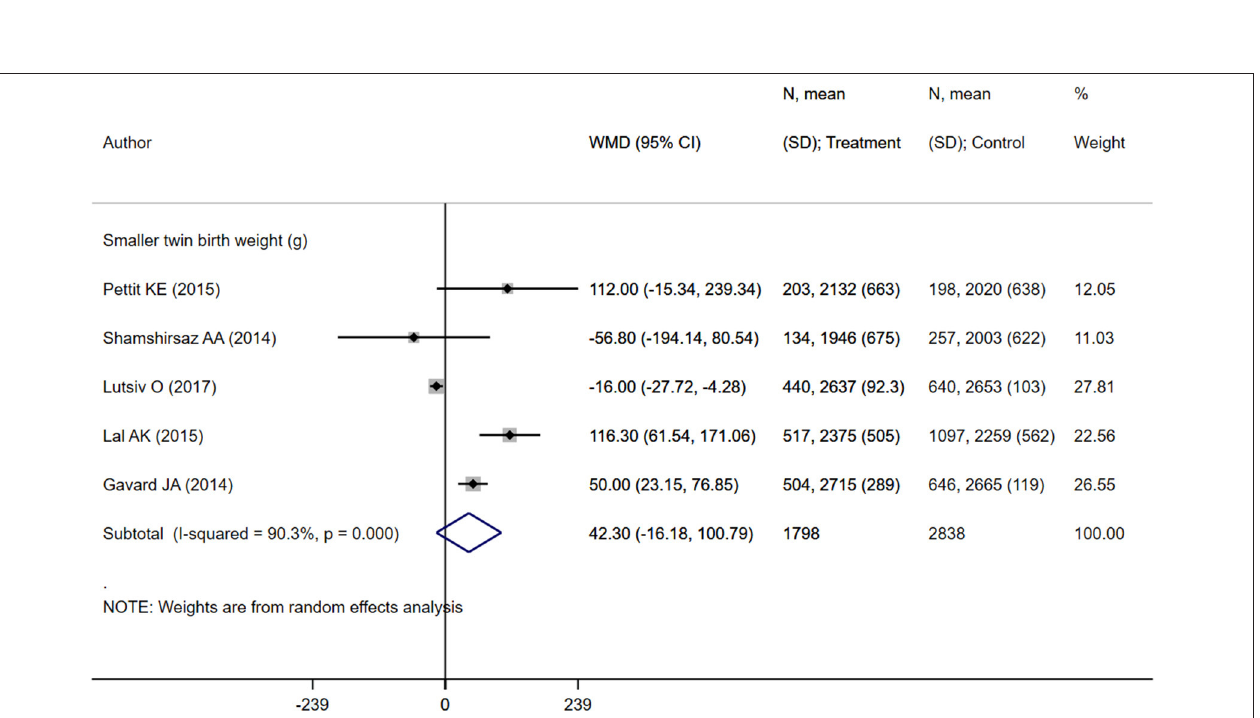
FIGURE 9 | Pooled analysis of excessive or adequate pregnancy weight gain effects on mean birth weight.